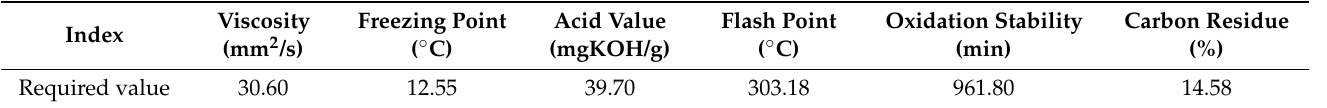
Table 4. Product index requirements.